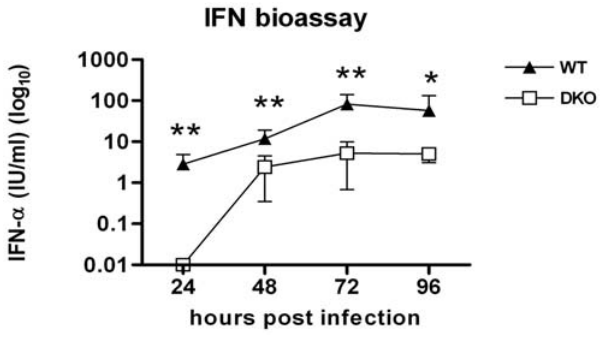
Figure 2. Levels of type I IFN levels in serum of wild type and DKO mice infected with WNV. Mice were inoculated with 10 2 PFU of WNV by footpad injection and sacrificed at the indicated times. Type I IFN levels were determined from serum collected on days 1 to 4 after WNV infection by an EMCV bioassay in L929 cells. Data reflect averages of serum samples from 5 to 10 mice per time point and the data are expressed as international units (IU) of IFN- a per ml. The specificity of the assay was confirmed with an anti-IFN- ab R neutralizing antibody (data not shown). Asterisks indicate values that are statistically significant (**, P , 0.005, *, P ,